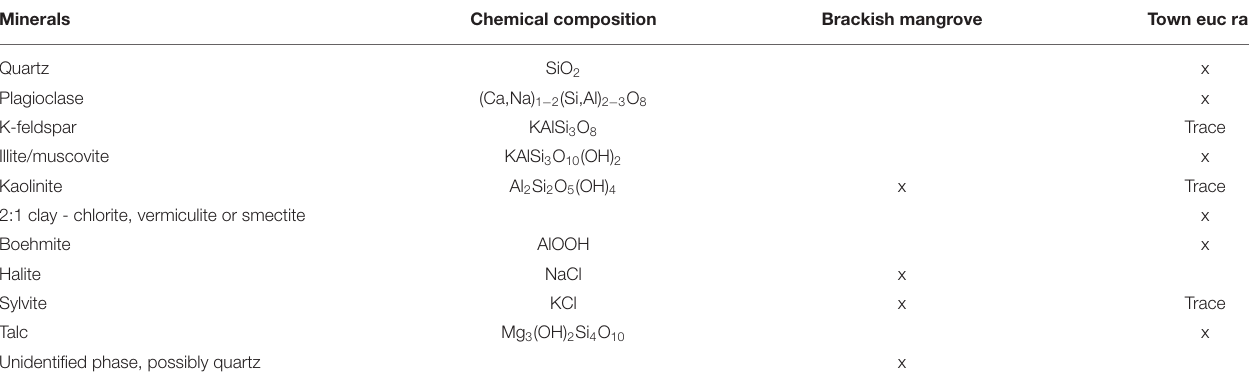
TABLE 2 | X-ray diffraction (XRD) results for the two leaf wash samples that were expected to have the most and least amounts of materials present on the surface; “Brackish mangrove” and “Town euc rain.” Minerals